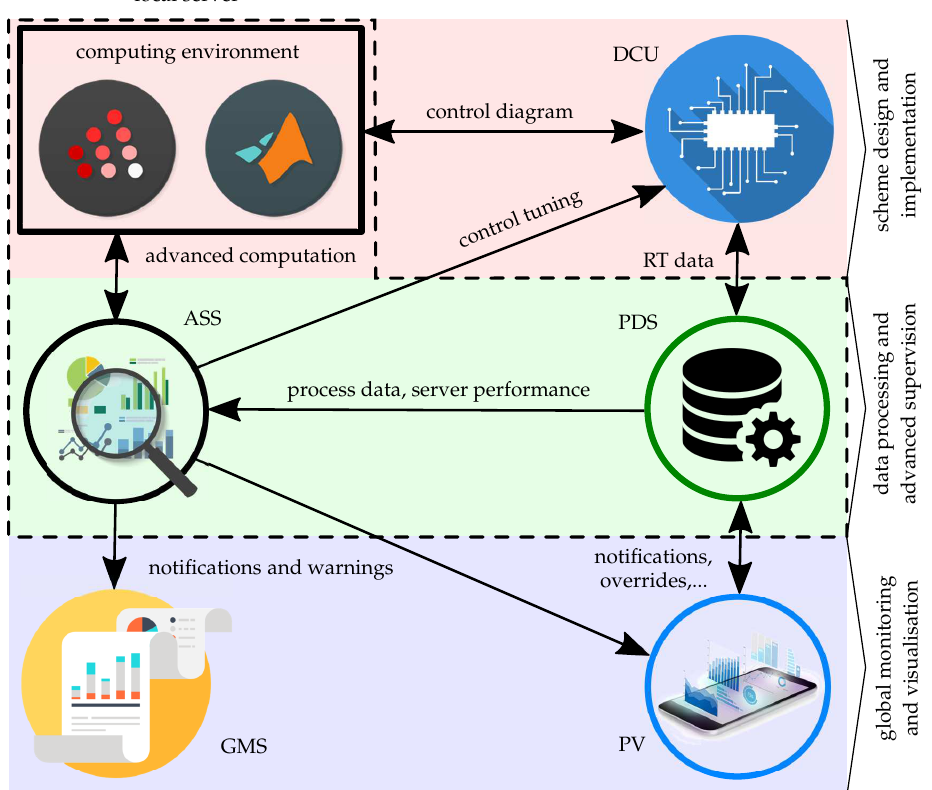
Figure 1. Simplified scheme of a global monitoring and control system. DCU—Dynamic Control Unit; ASS—Advanced Supervision Server; PDS—Process Data Server; GMS—Global Monitoring System; and, PV—Process